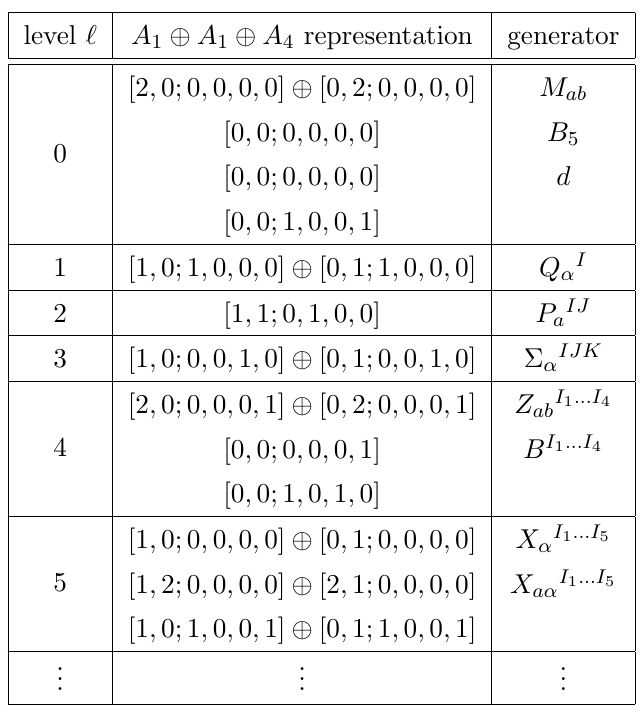
Table 7 . The non-negative levels of E 6++ (the hyperbolic extension of E 6 ) with Dynkin diagram in (cid:12)gure 2 for k = 5, decomposed with respect to the A 1 (cid:8) A 1 (cid:8) A 4 subalgebra obtained by removing node 2 and 3. The Dynkin labels of A 4 are separated from those of A 1 (cid:8) A 1 with a semicolon. Restricting to A 4 representations where the ‘ -th Dynkin label is equal to one and the others to zero (all zero for ‘ = 0 and ‘ = 5) we obtain the A 1 (cid:8) A 1 representations B ‘ in table 2. We